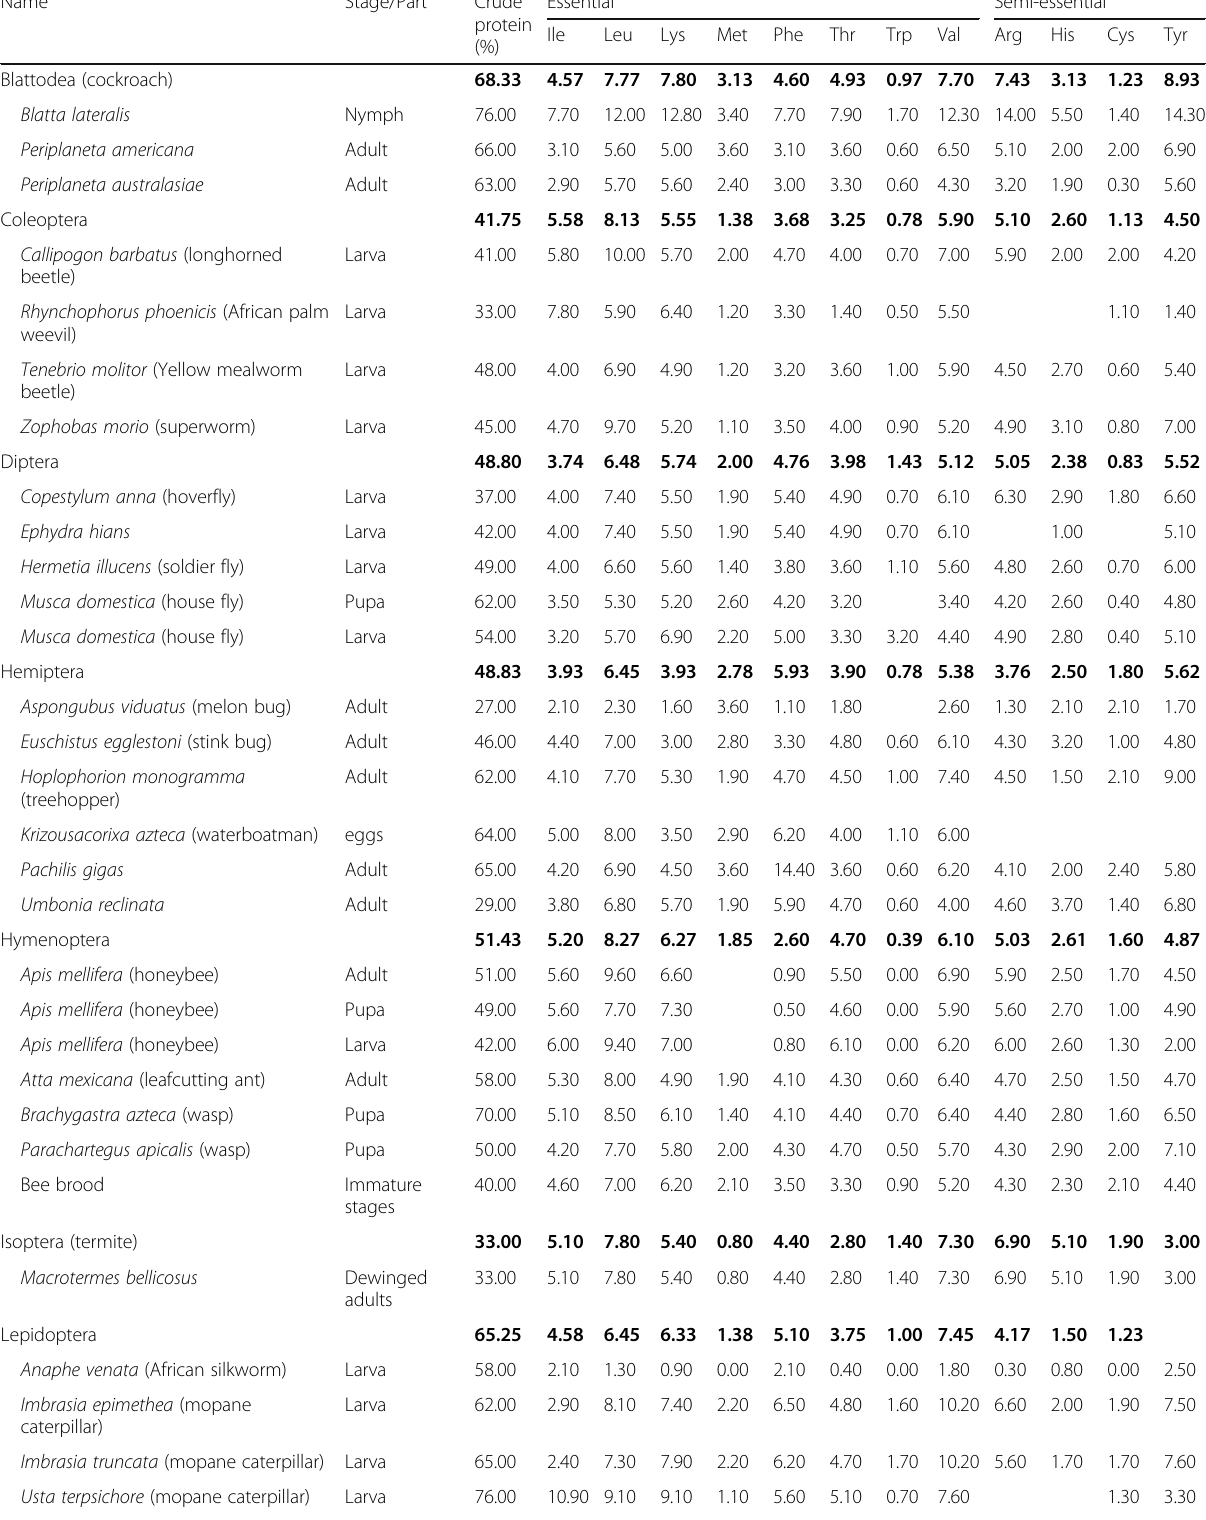
Table 1 Amino acid content of common edible insects (% in crude protein of dry